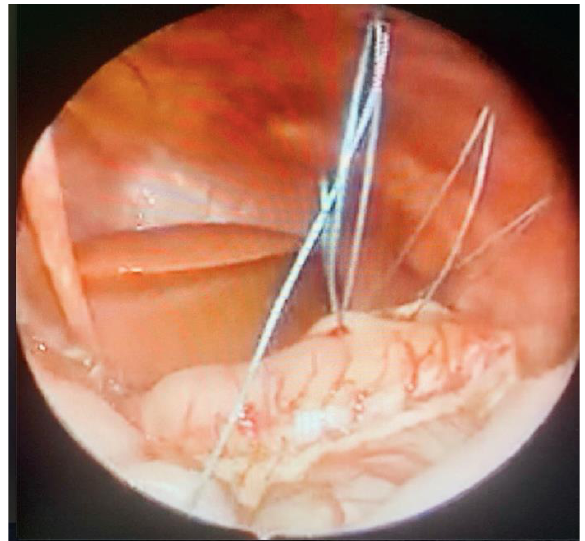
Figure 5. Intraoperative image: positioning of seromuscular thread within the stomach’s greater curvature and the anterior abdominal muscle wall.